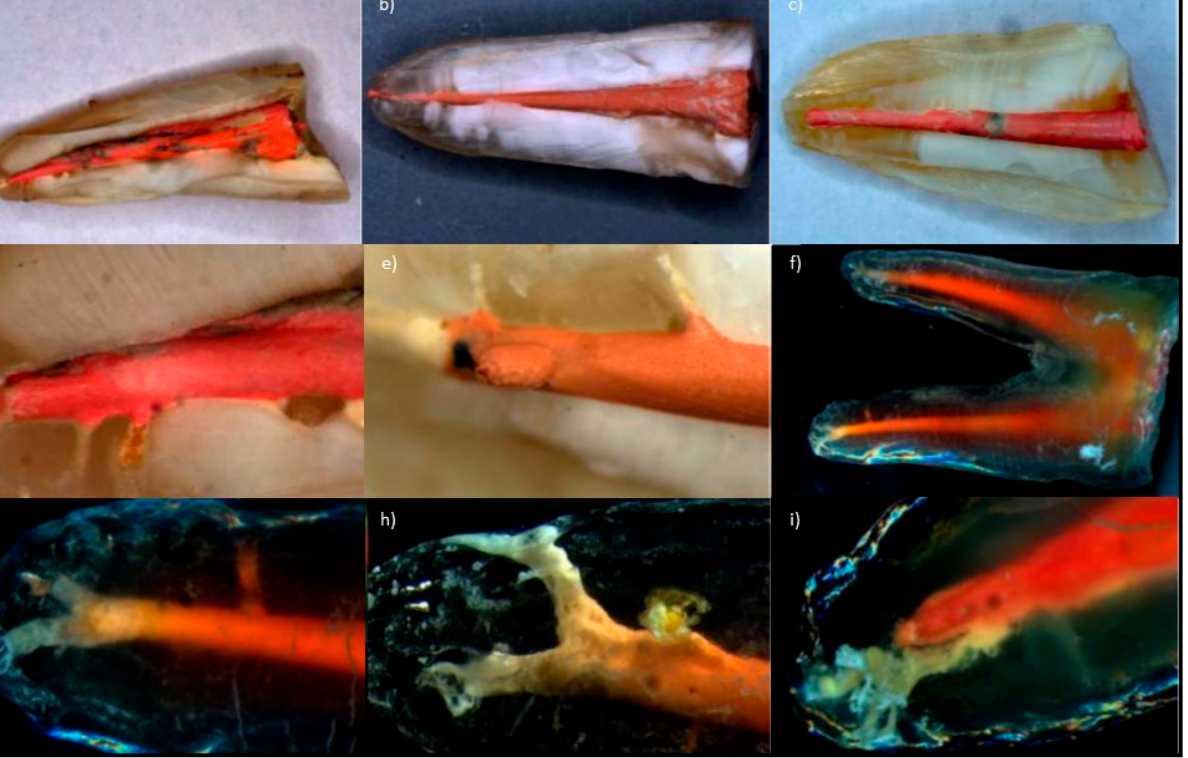
Figure 8. View of the tooth roots: ( a – c ) longitudinal breakthrough of the tooth root filled with gutta-percha material and sealant: ( a ) cold, ( b ) thermoplastically with a plasticizer, and ( c ) thermoplastically with THC; ( d , e ) lateral tubules in the apical part of the root canal filled with material based on a gutta-percha: ( d ) first at the apical side filled with sealant, and ( e ) both centrifugally filled with sealant; ( f – i ) teeth prepared by the decalcification technique: ( f ) two-root tooth with a root delta in each root, ( g – i ) and root canal delta filled with sealant viewed with an LSM.